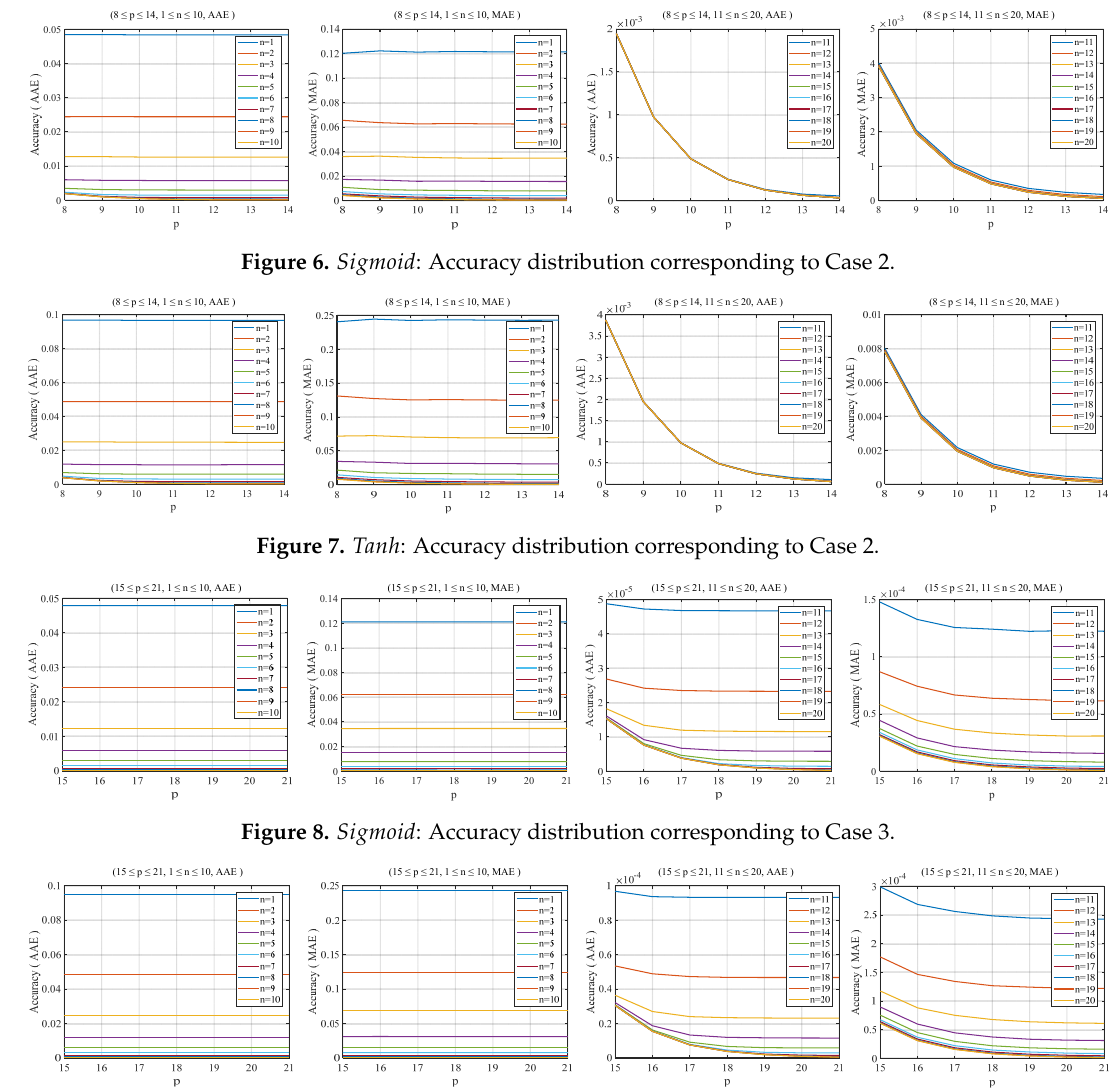
Figure 9. Tanh : Accuracy distribution corresponding to Case